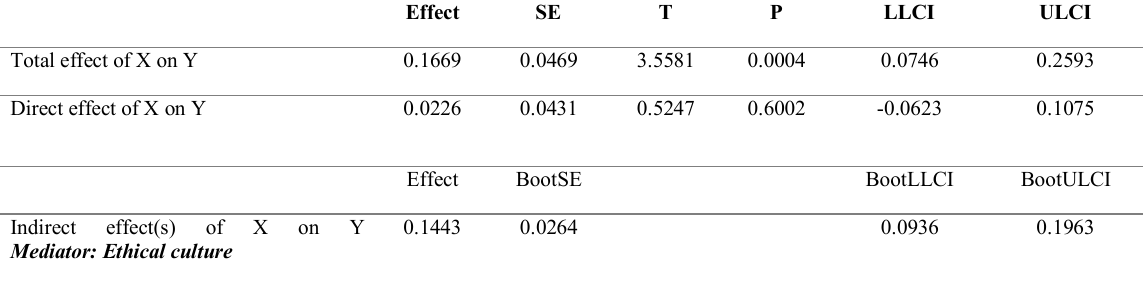
Table 3: The mediating effect of corporate ethical